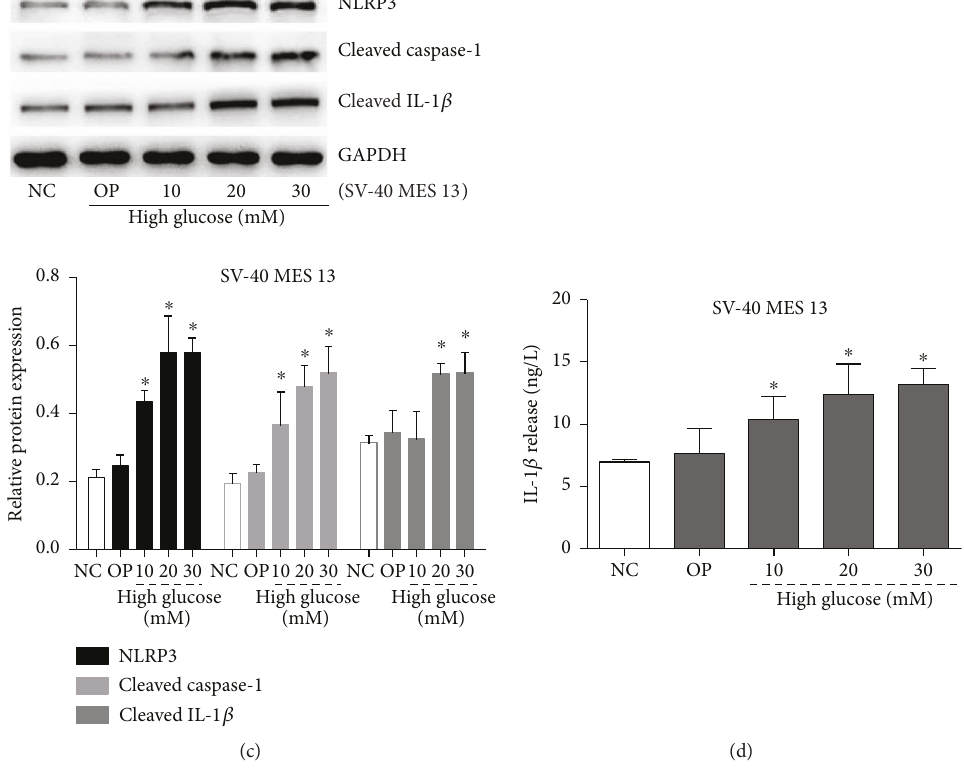
Figure 3: High glucose inhibited the expression of STRs and activated NLRP3 in fl ammasome. (a) GMCs (SV-40 MES 13) and human proximal tubular cells (HK-2) were treated with 30 mmol/L high glucose for 6, 12, and 24 h, and Western blot or qRT-PCR was performed to detect T1R2 and T1R3 protein or mRNA expression levels. (b) Cells were treated with the indicated concentrations of glucose or mannitol for 24h. Western blot or qRT-PCR was performed to detect T1R2 and T1R3 protein or mRNA expression levels. (c) Western blotting analysis of NLRP3, cleaved caspase-1, and cleaved IL-1 β in GMCs treated with an indicated concentration of glucose or mannitol for 24h. (d) IL-1 β protein level in the GMC culture supernatant was determined by ELISA. Data are expressed as mean ± SD. ∗ p < 0 05 versus NC